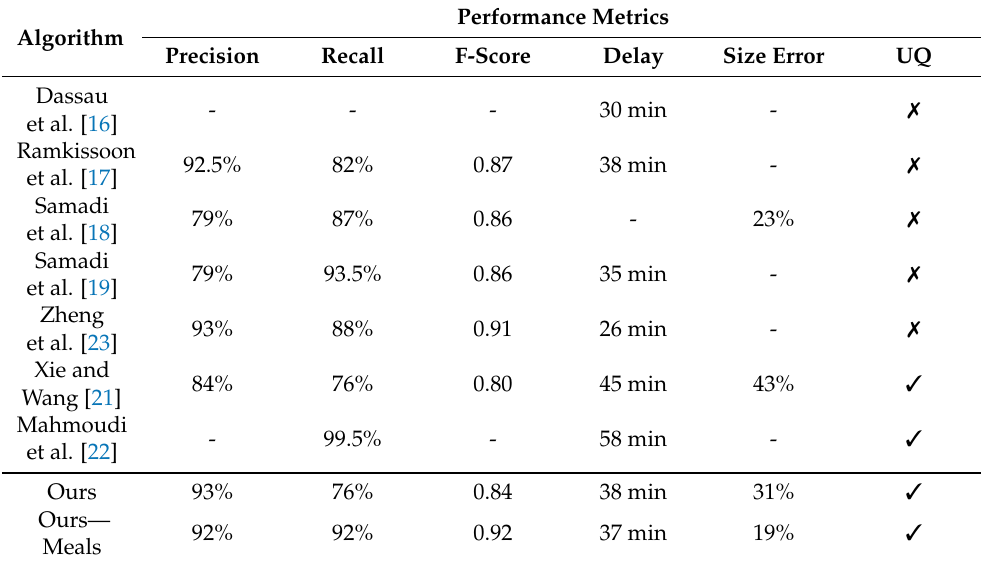
Table 3. A comparison of reported performance metrics in the literature for automatic meal detection and estimation algorithms with our proposed